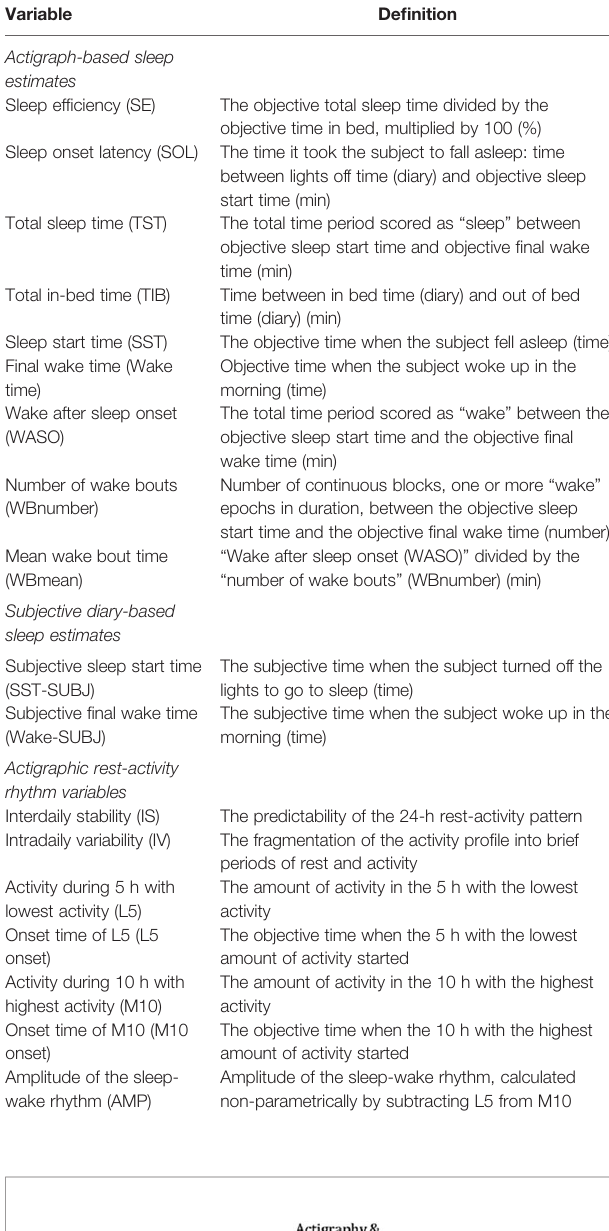
TABLE 1 | Sleep variable de fi